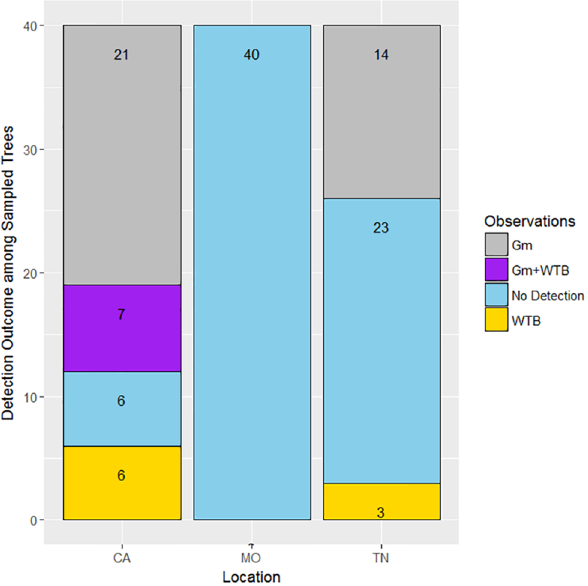
Fig 2. Molecular detection outcomes among 40 samples each from California ( Juglans hindsii ), Missouri (control, Juglans nigra ) and Tennessee ( J . nigra ) for both drilling